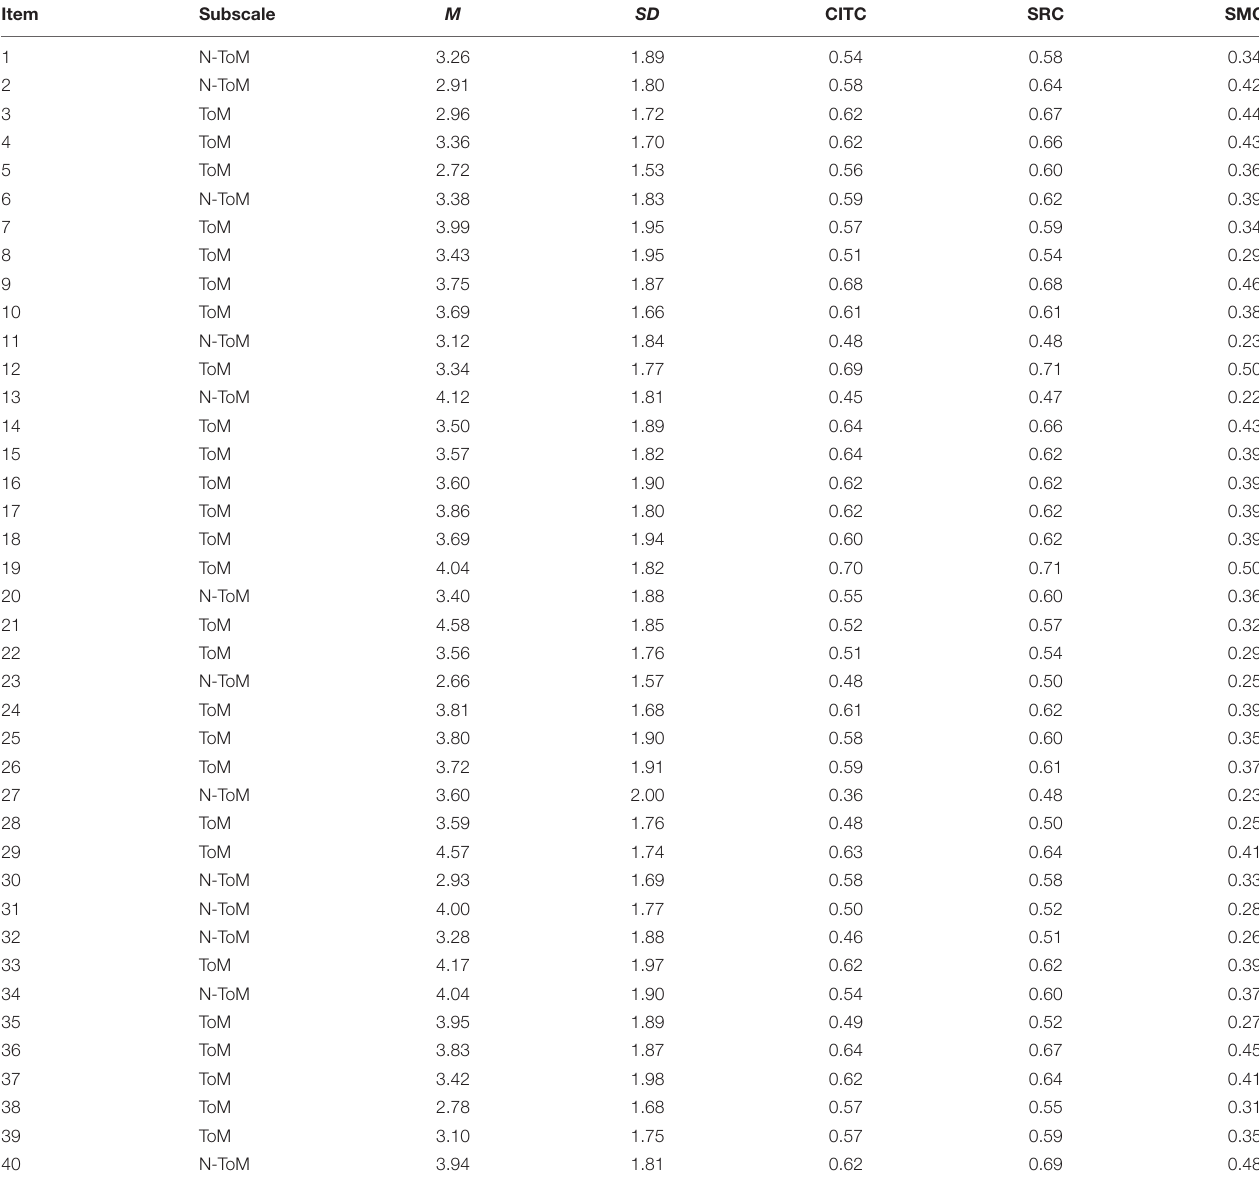
TABLE 1 | Psychometric characteristics of the